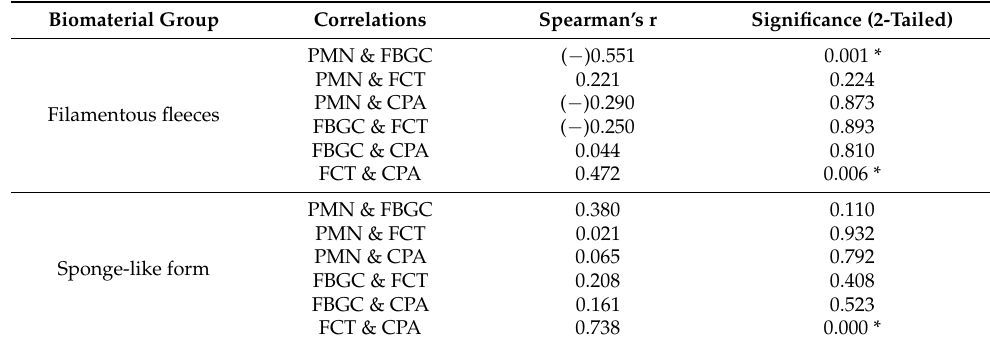
Table 1. Bivariate correlations (Spearman) between variables of the FBR regarding the biomate- rial